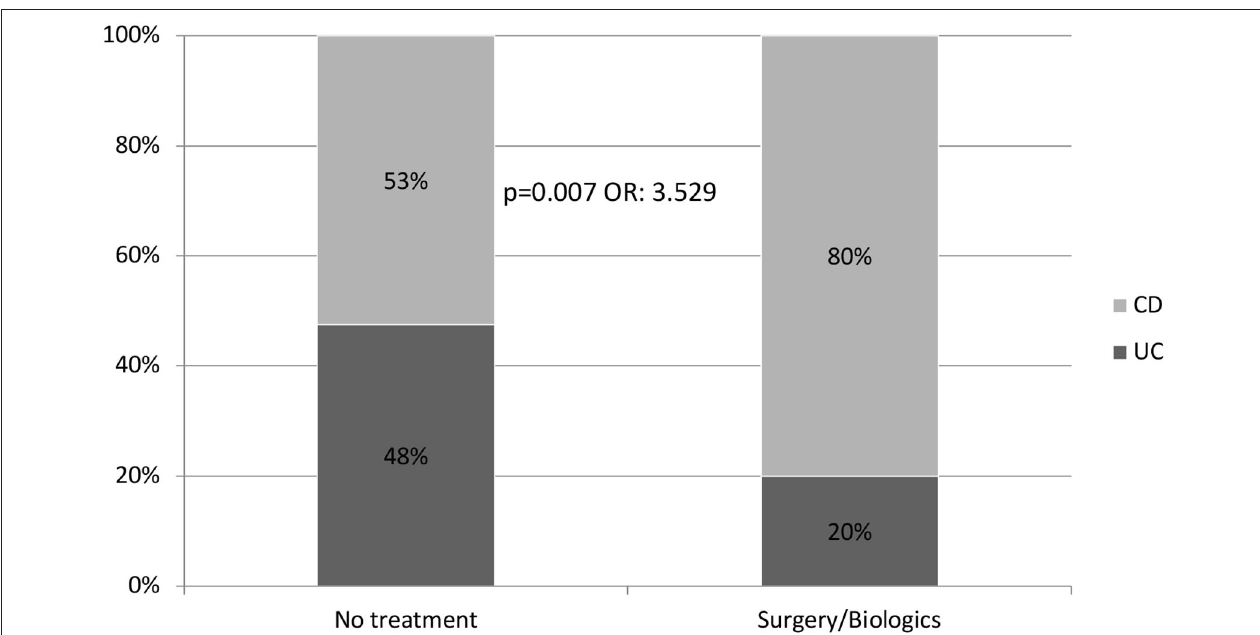
FIGURE 2 | Probability of receiving biological treatment and/or surgery during follow-up after receiving steroids (89 patients).